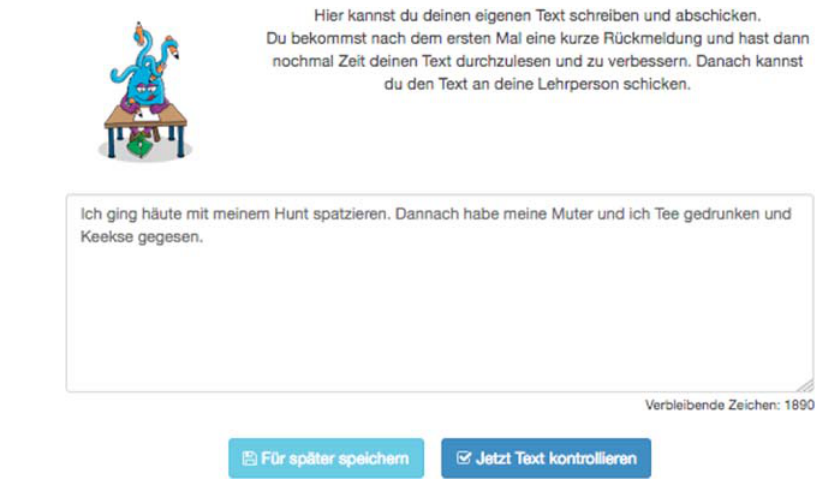
Figure 6. Start writing a text on the